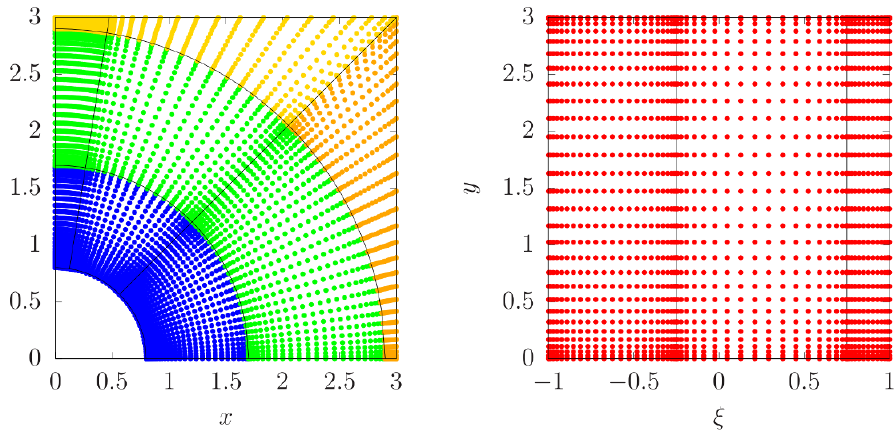
Figure 13 . Physical grid with parameters: L = 6, r 0 = 0 : 8, r (cid:3) = 1 : 7 and r 1 = 2 : 9, a (cid:3) = 0 : 9 (cid:2) ( (cid:25)= 2), (cid:24) (cid:3) = (cid:0) 0 : 25, (cid:24) (cid:3)(cid:3) = 0 : 75, (cid:31) 1 = 2 : 5 and (cid:31) 2 = 3. Near patch (left) and far patch (right) in terms of the compacti(cid:12)ed (cid:24)